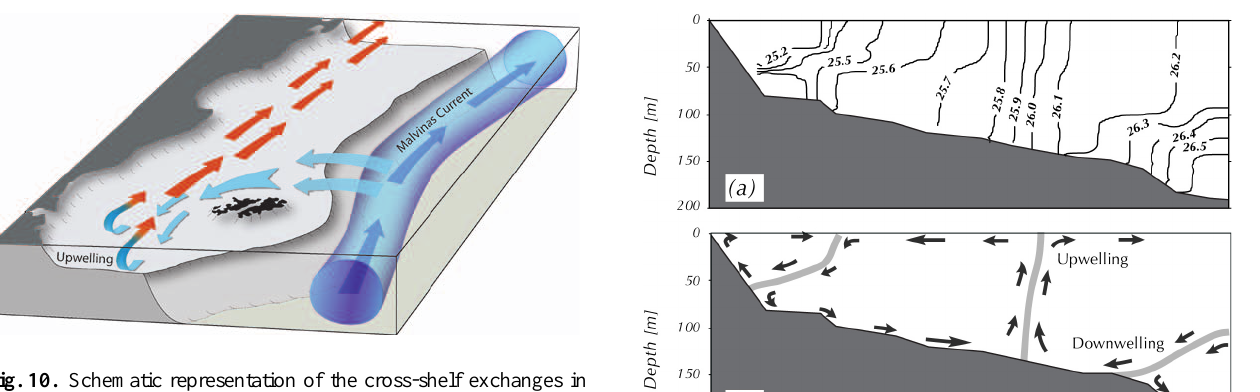
Fig. 10. Schematic representation of the cross-shelf exchanges in the Patagonia shelf region. Sub Antarctic waters upwelled along Patagonia’s shelfbreak move onshelf and sink. Near the coast these waters are drawn upward by tidal mixing, and after reaching the surface they are advected to the north by the westerly winds. A portion of these waters is likely to be diverted offshore in the surface Ekman layer while the remainder might reach the Brazil/Malvinas Confluence and the STSF where they are likely to be detrained by the mean circulation.